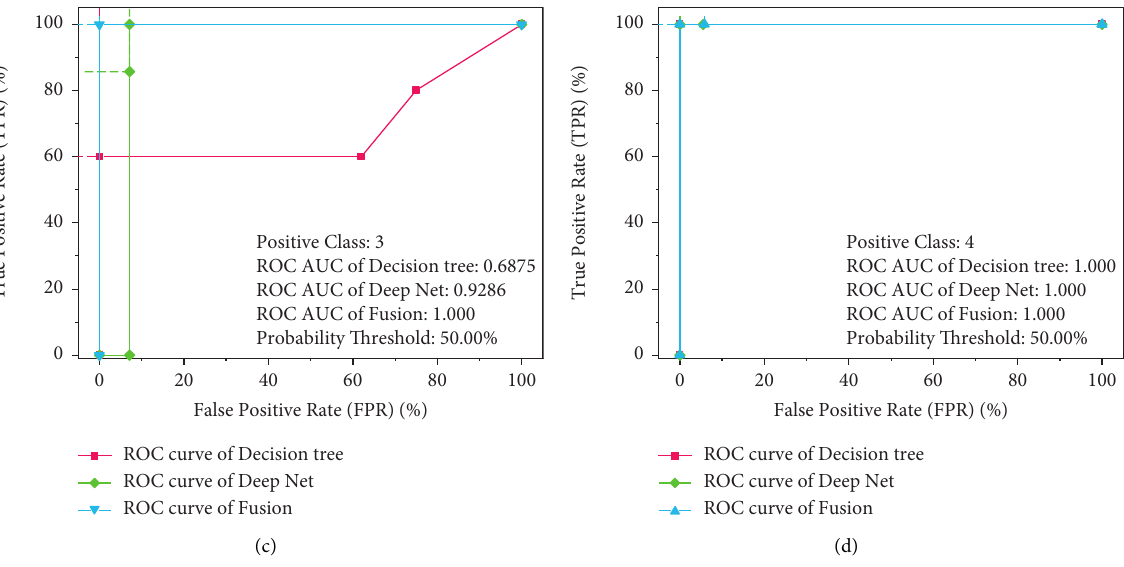
Figure 18: ROC curve of each classification test of the fusion model.